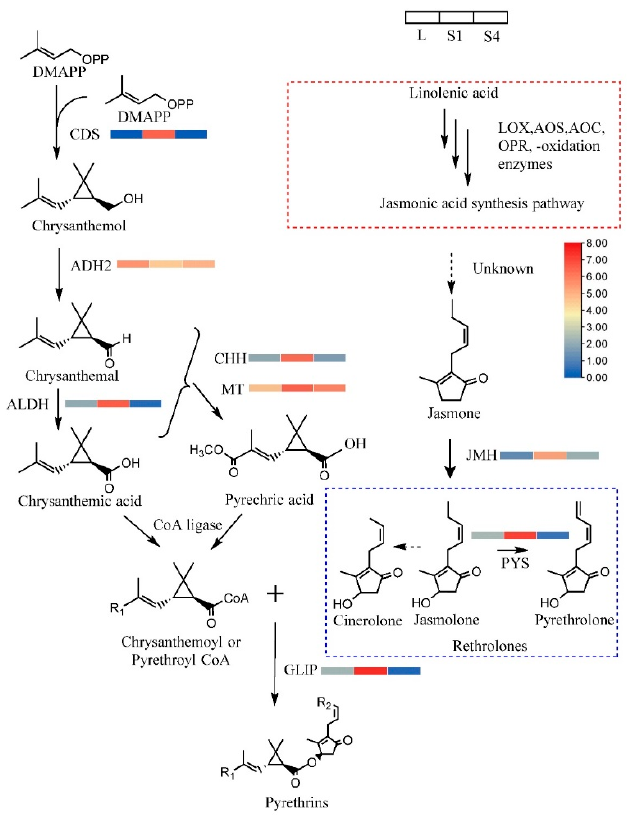
Figure 4. The biosynthesis of pyrethrin and gene expression. The color shows the normalized expression score from log 2 (FPKM+1) of DEGs. Solid arrows indicate known steps in the pathway, dotted arrows indicate steps not yet elucidated, red dotted box indicates the JAs synthesis pathway, blue dotted box indicates the rethrolones, a pyrethrin molecule incorporates one of three rethrolones. Abbreviations: CDS, chrysanthemol synthase; ADH2, alcohol dehydrogenase 2; ALDH, aldehyde dehydrogenase; CHH, chrysanthemol 10-hydroxylase; MT, 10-carboxychrysanthemic acid 10-methyltransferase; PYS, pyrethrolone synthase; JMH, jasmolone hydroxylase; GLIP, GDSL lipase-like protein.